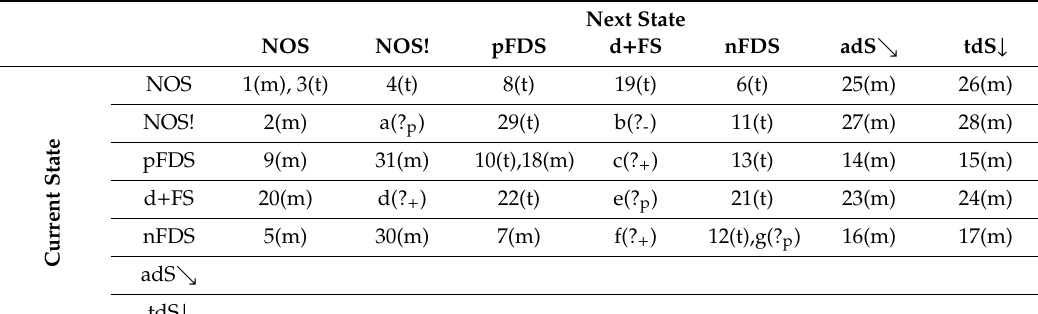
Table 1. State transition table of the condensed version of the FSM model proposed in [1,2] consisting of the state names; the indexes 1–31, which represent the transitions associated with the causing event (t for any threats, m for management decisions improving the current functionality and performance, finishing the heightened awareness, or inducing a final state); the transitions a to g together with the inputs (? + ), (? - ) and (? p ), which illustrate the transitions discounted by [1,2]. Next State NOS NOS! pFDS d + FS nFDS adS (cid:38) tdS ↓ NOS 1(m), 3(t) 4(t) 8(t) 19(t) 6(t) 25(m) 26(m) NOS! 2(m) a(? p ) 29(t) b(? - ) 11(t) 27(m) 28(m) e pFDS 9(m) 31(m) 10(t),18(m) c(? + ) 13(t) 14(m) 15(m) a t S t d + FS 20(m) d(? + ) 22(t) e(? p ) 21(t) 23(m) 24(m) n t e rr nFDS 5(m) 30(m) 7(m) f(? + ) 12(t),g(? p ) 16(m) 17(m) u C adS (cid:38) tdS